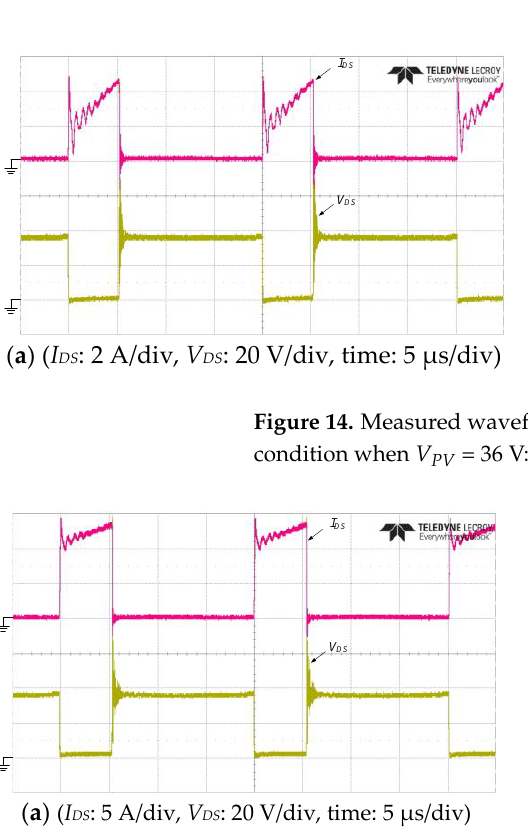
25 of 31 Table 4. Specifications of solar panel. Parameters